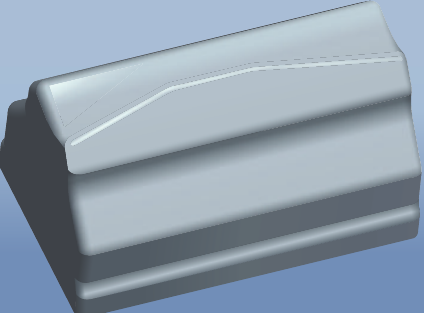
Figure 1: Geometric model of hammer.